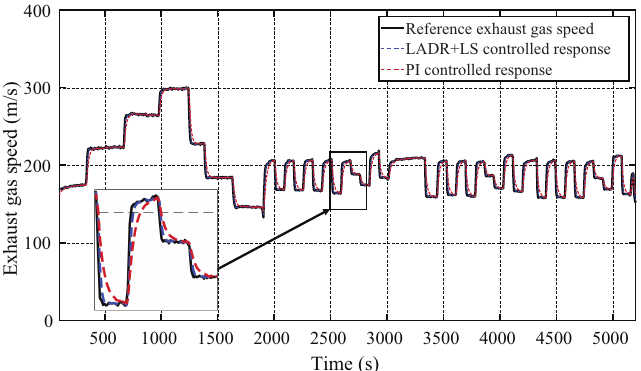
Figure 18. Reference tracking for the velocity to achieve optimal expansion of the exhaust